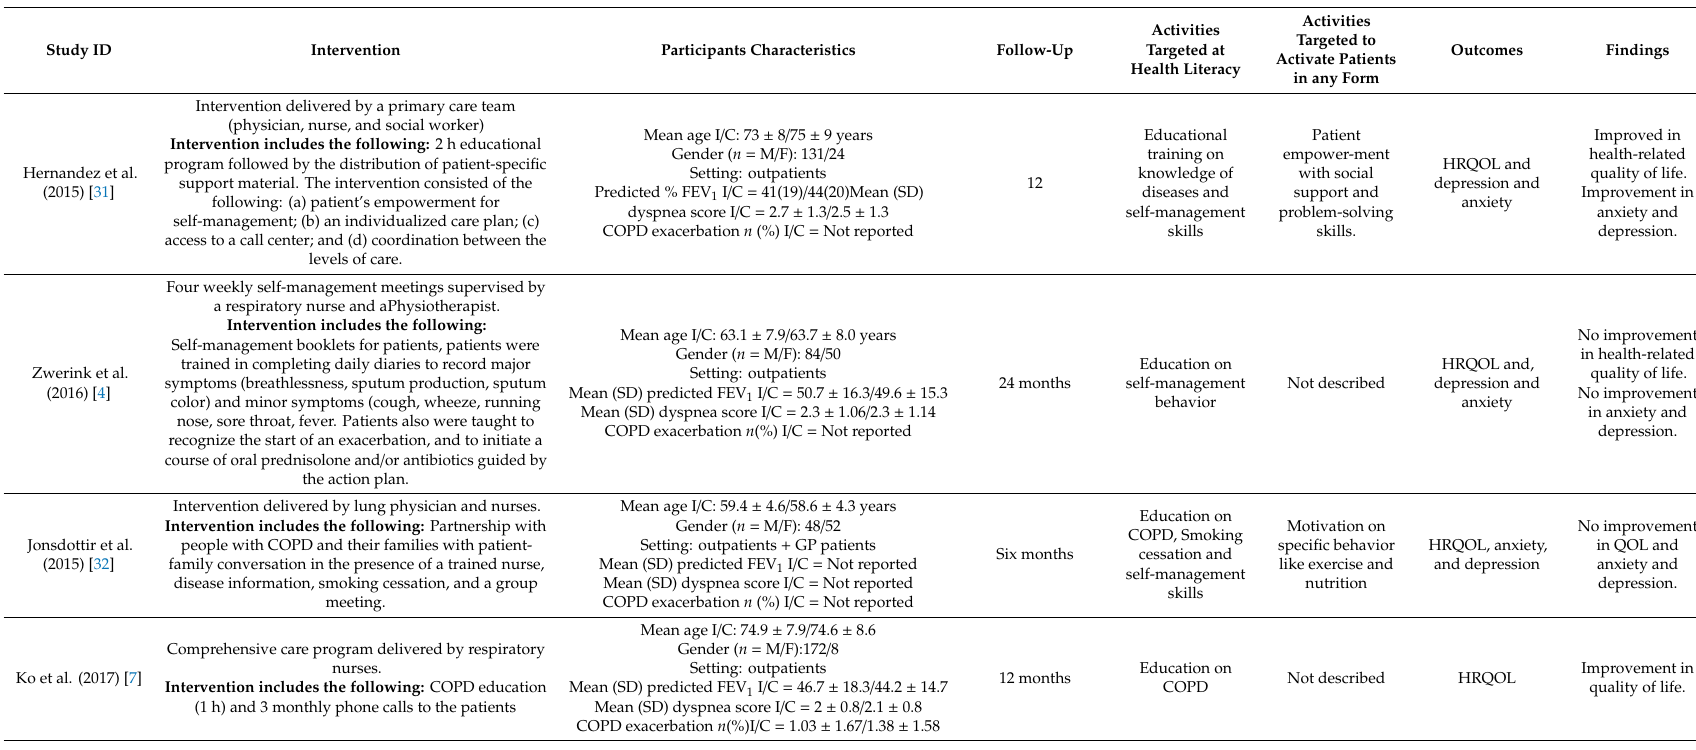
Intervention Participants Characteristics Follow-Up